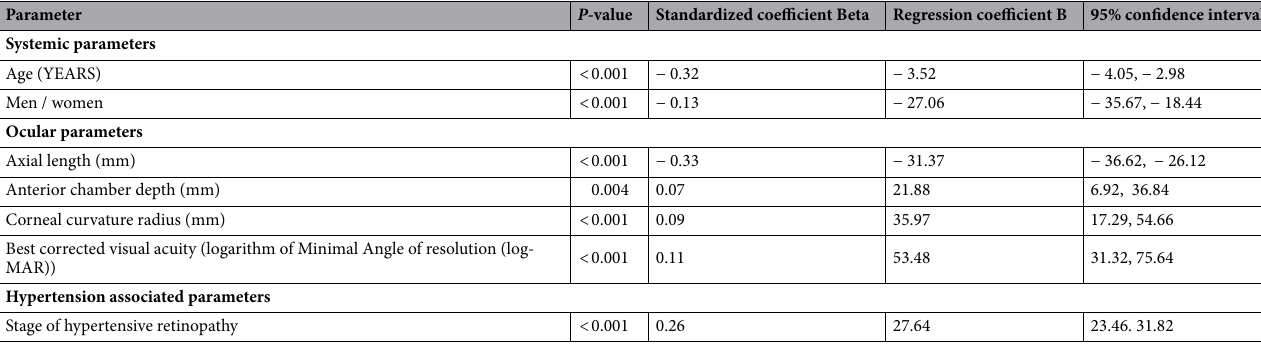
Table 2. Associations between the subfoveal choroidal thickness and systemic and ocular parameters in the Beijing Eye Study 2011.